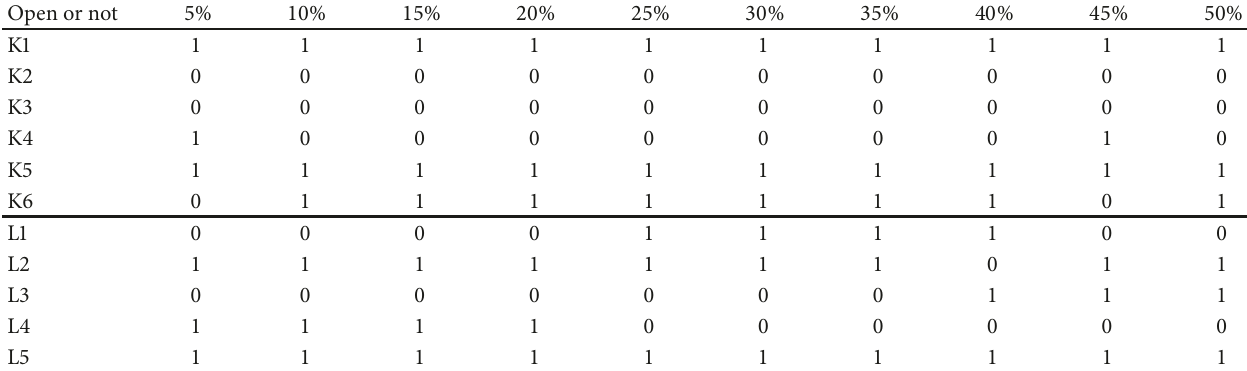
Table 18: Impact of nonferrous components’ selling price on choice of opening